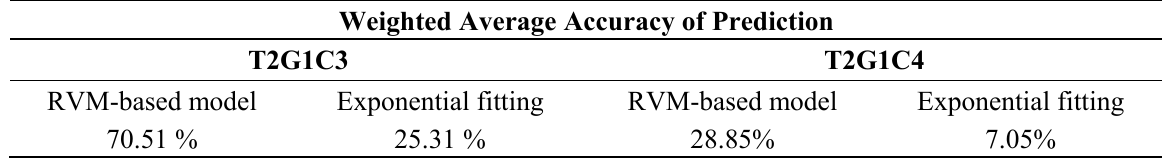
Table 4. The weighted average accuracy of the prediction for pump